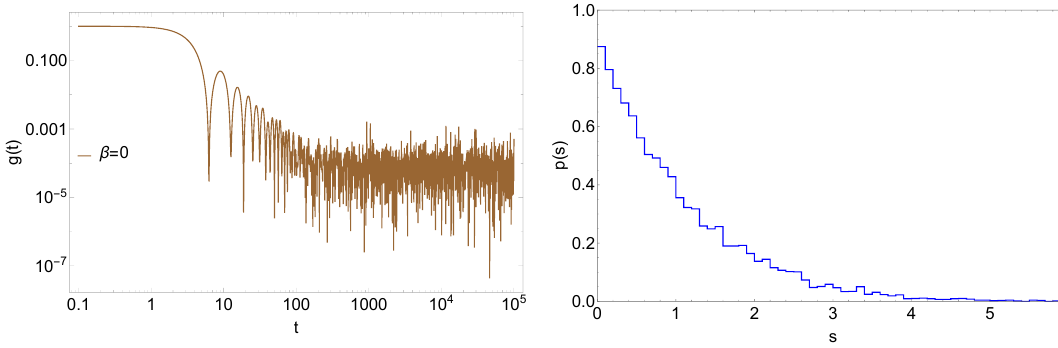
Figure 17. SFF and level spacing for square mod system with j cut = 10000 and α = π .